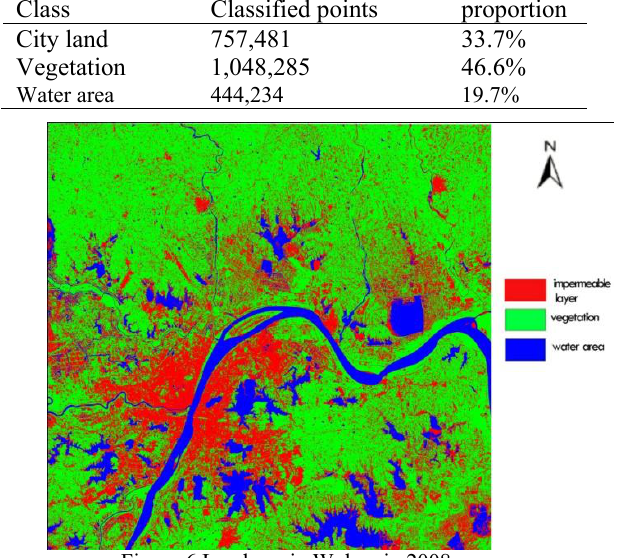
Table 3. Land use classification.